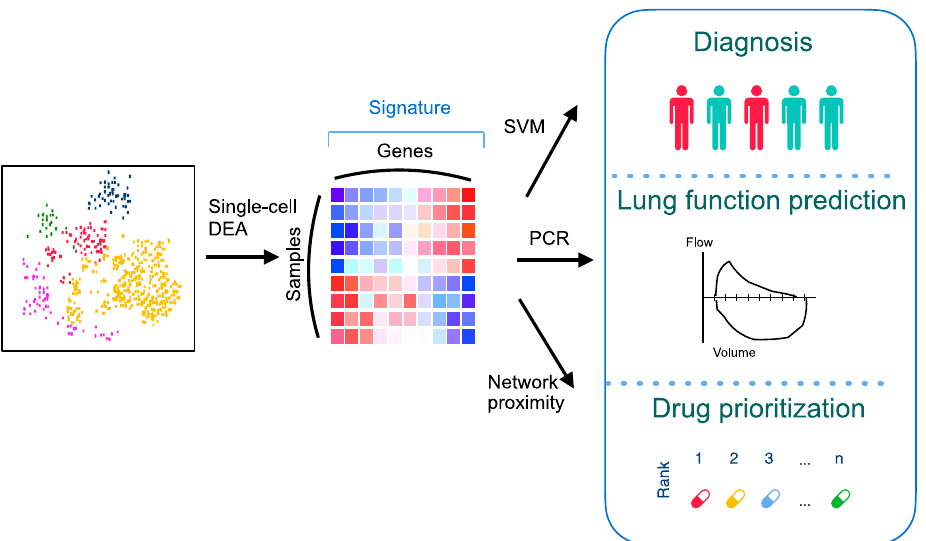
Figure 1. An overall analytical pipeline of this study. Schematic representation of the scRNA-seq analysis, signature construction, and application of the signature by integrating various computational methods. DEA: differential expression analysis; PCR: principal component regression; SVM: support vector machine.